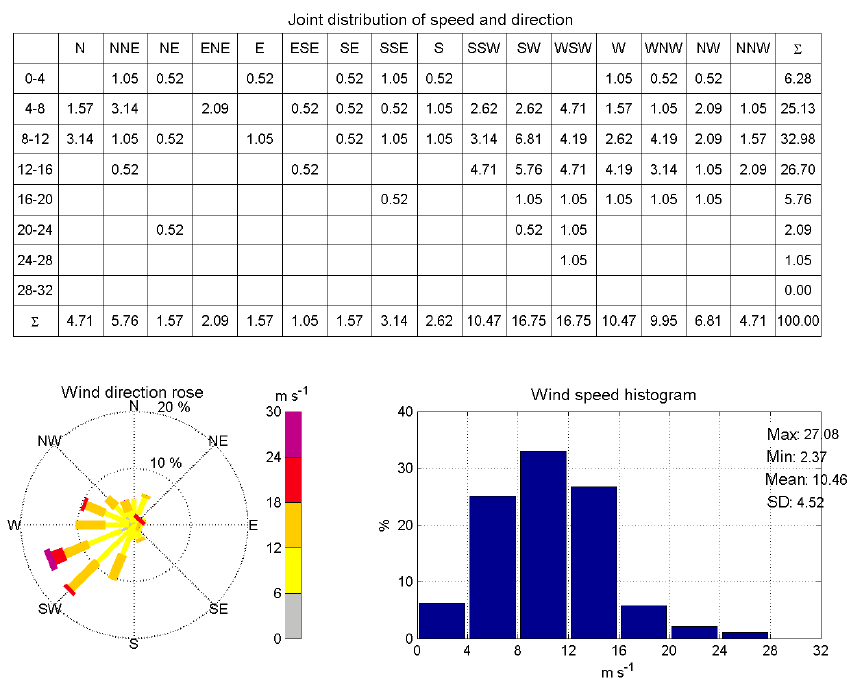
Figure 8. For the 191 cases where there was no wind decrease downstream of warm-core eddies: distribution in % and ms − 1 of wind speed and direction (top); left: wind direction rose (bottom left) and wind speed histogram (bottom right) at the entrance of the eddy upstream.